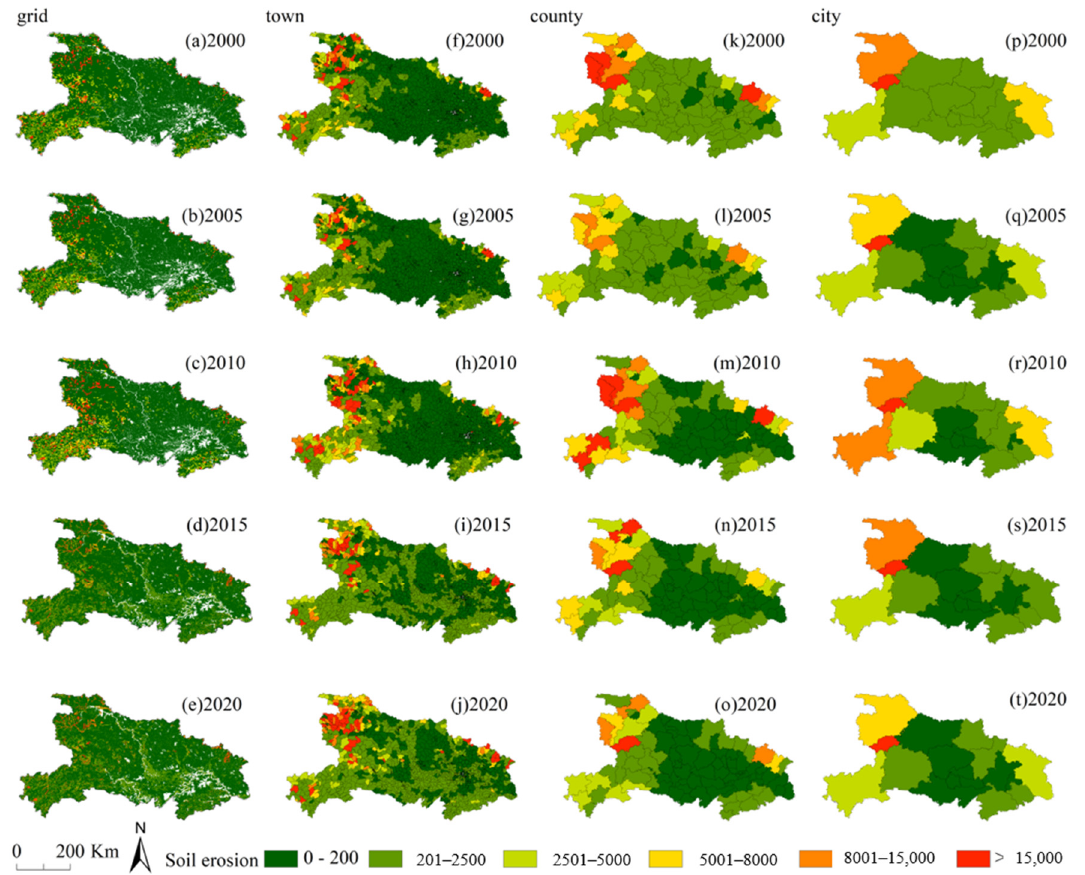
Figure 3. The average soil erosion rate at the ( a – e ) gird scale, ( f – j ) town scale, ( k – o ) county scale, and ( p – t ) city scale